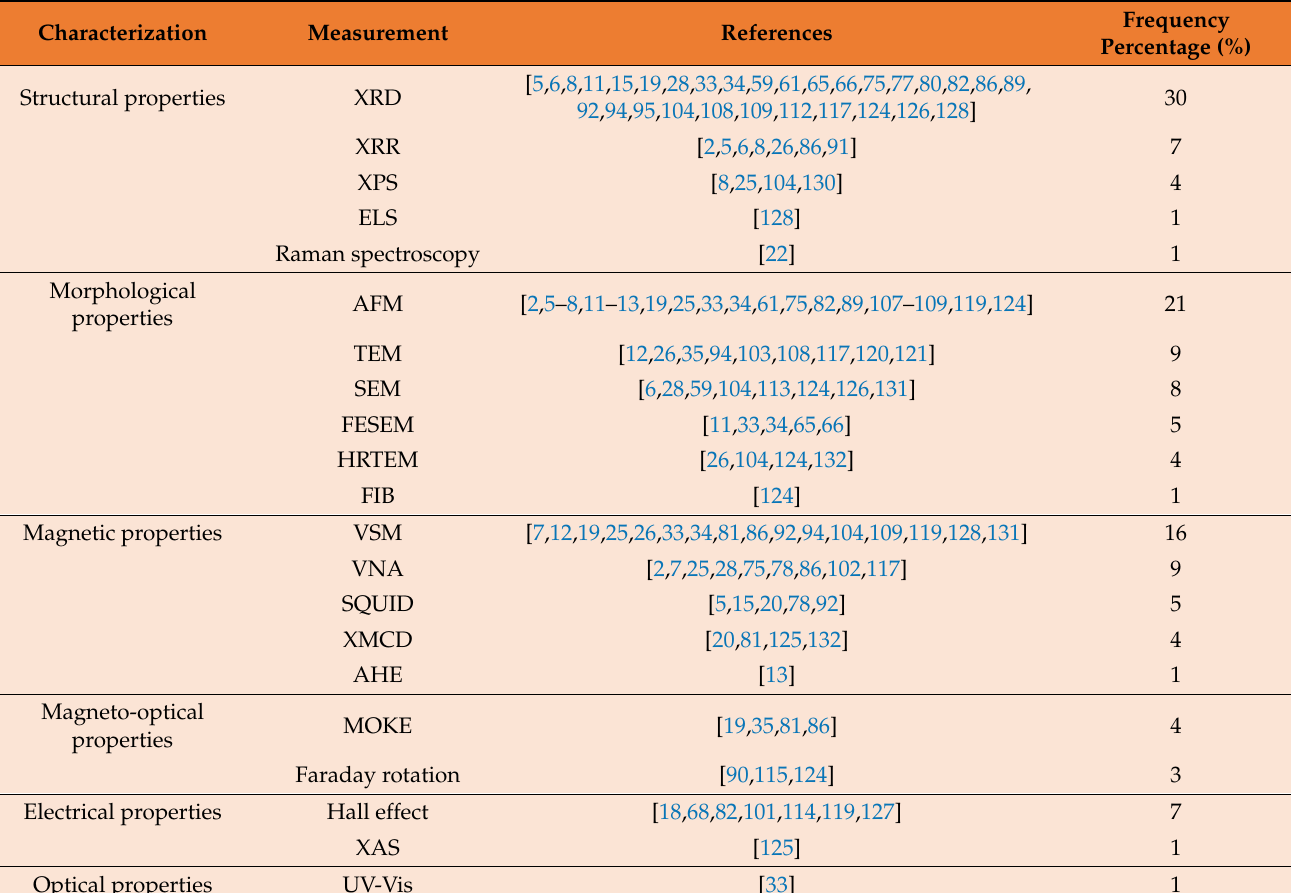
Figure 5. The characterization of YIG with the different measurements for the top 100 cited articles. Table 4. Frequency of the film’s characterization.